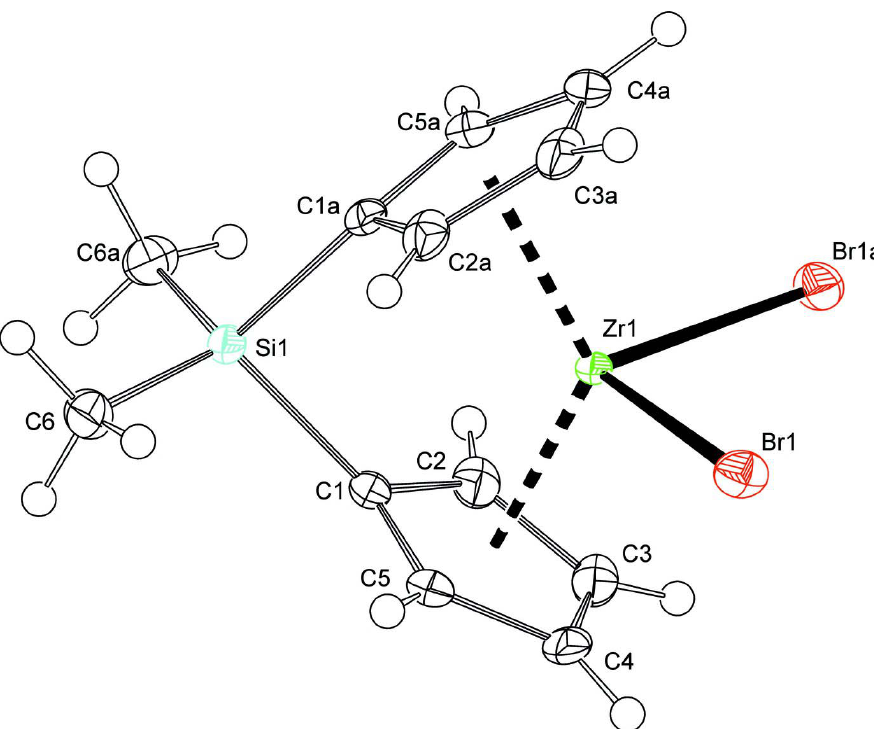
Figure 1 Perspective view of (I), shown with 30% probability displacement ellipsoids (arbitrary spheres for H atoms) [symmetry code: ( a ) - x , y , 1 / - z 2